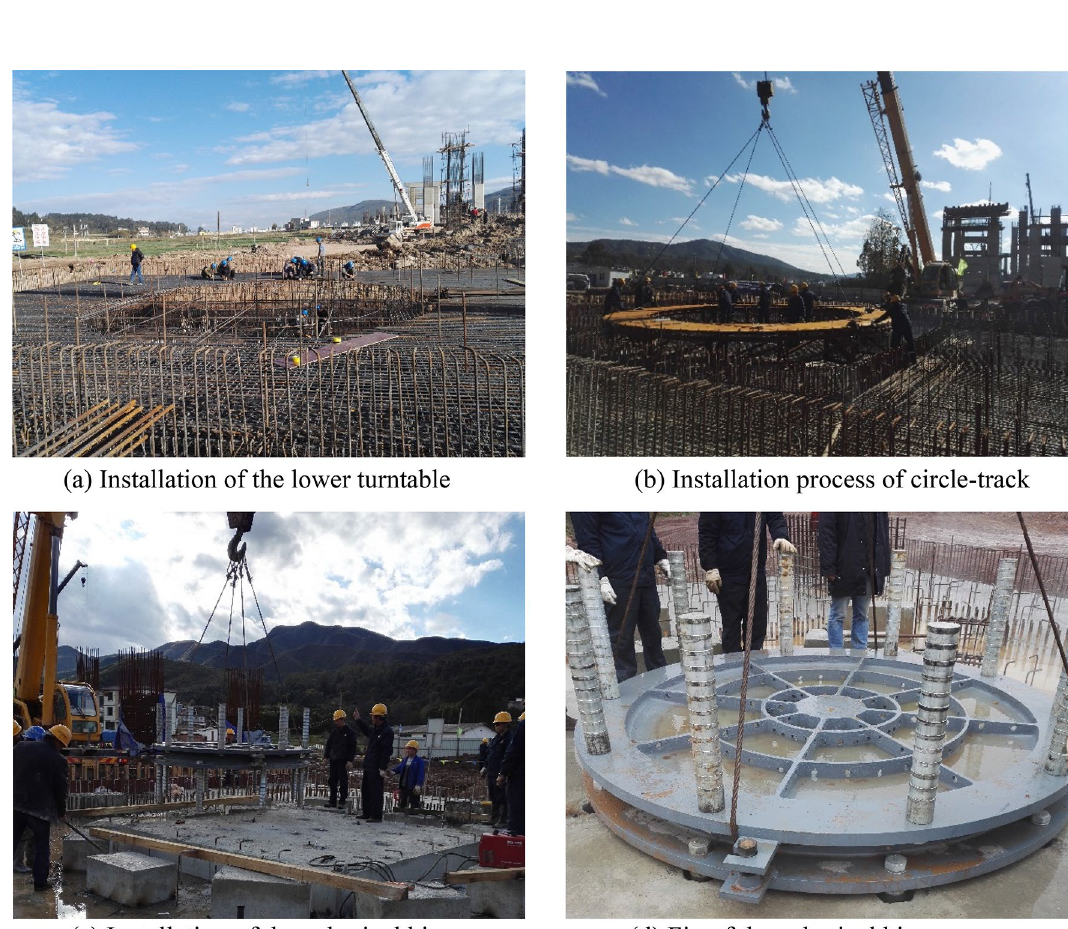
Figure 4. Installation process of the spherical